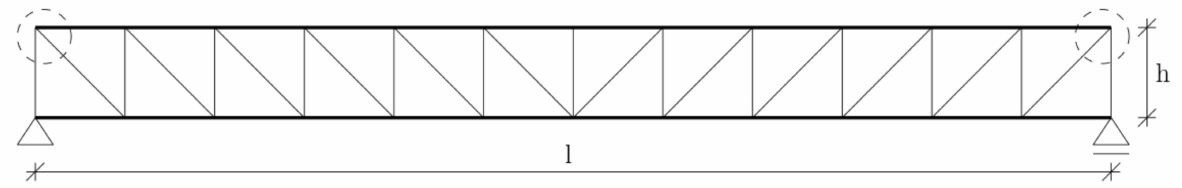
Figure 12. Location of the most efforted truss joints.